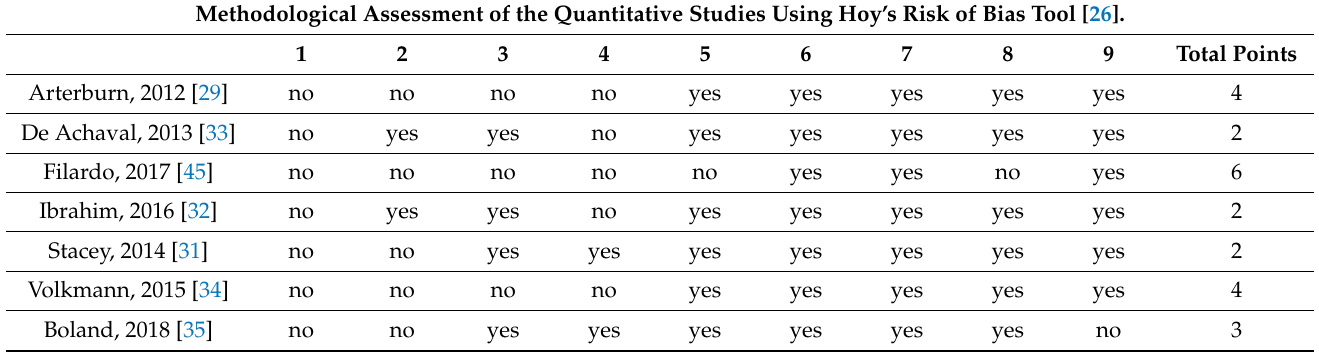
Table A4. Methodological assessment of the quantitative studies using Hoy’s Risk of bias tool. Methodological Assessment of the Quantitative Studies Using Hoy’s Risk of Bias Tool [26].